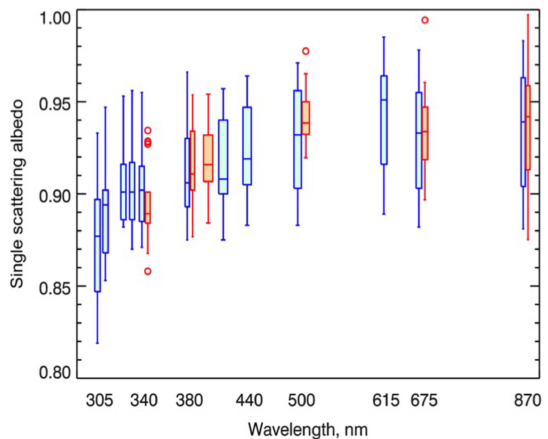
Figure 9. Combined spectral SSA from AMP retrievals (blue sym- bols) and SKYNET retrievals (orange symbols) using MODIS- derived surface albedo. The bottom and top edges of the boxes are located at the sample 25th and 75th percentiles; the whiskers ex- tend to the minimal and maximal values within 1.5 IQR (interquar- tile range). The outliers are shown in circles. The center horizontal lines are drawn at the median values. The whisker boxes are com- puted using AOD440 ≥ 0 . 4 criteria to correspond the best quality level 2 AERONET data. Cited from Mok et al. (2018).